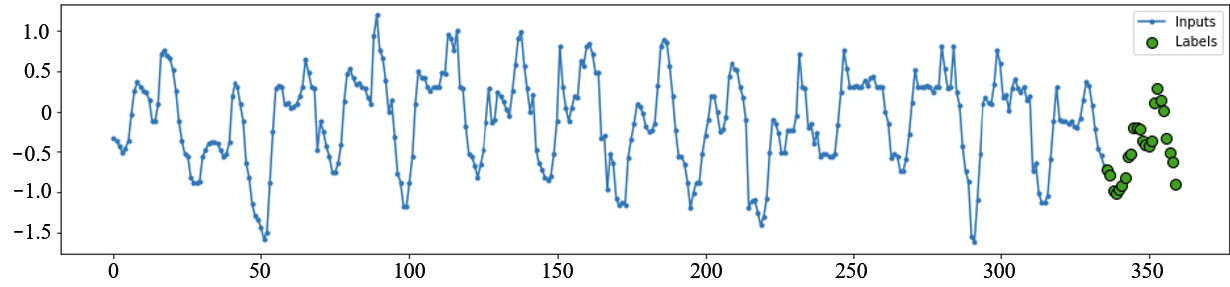
Figure 3. Example data windows with inputs and labels.